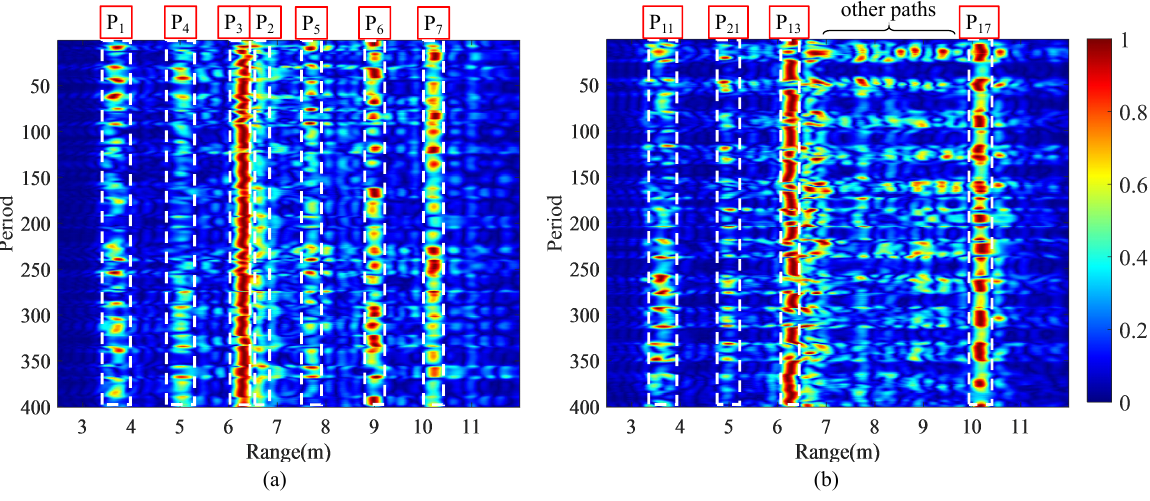
Figure 3. Range profiles in the L-shaped corner scenario for ( a ) single target and ( b ) double